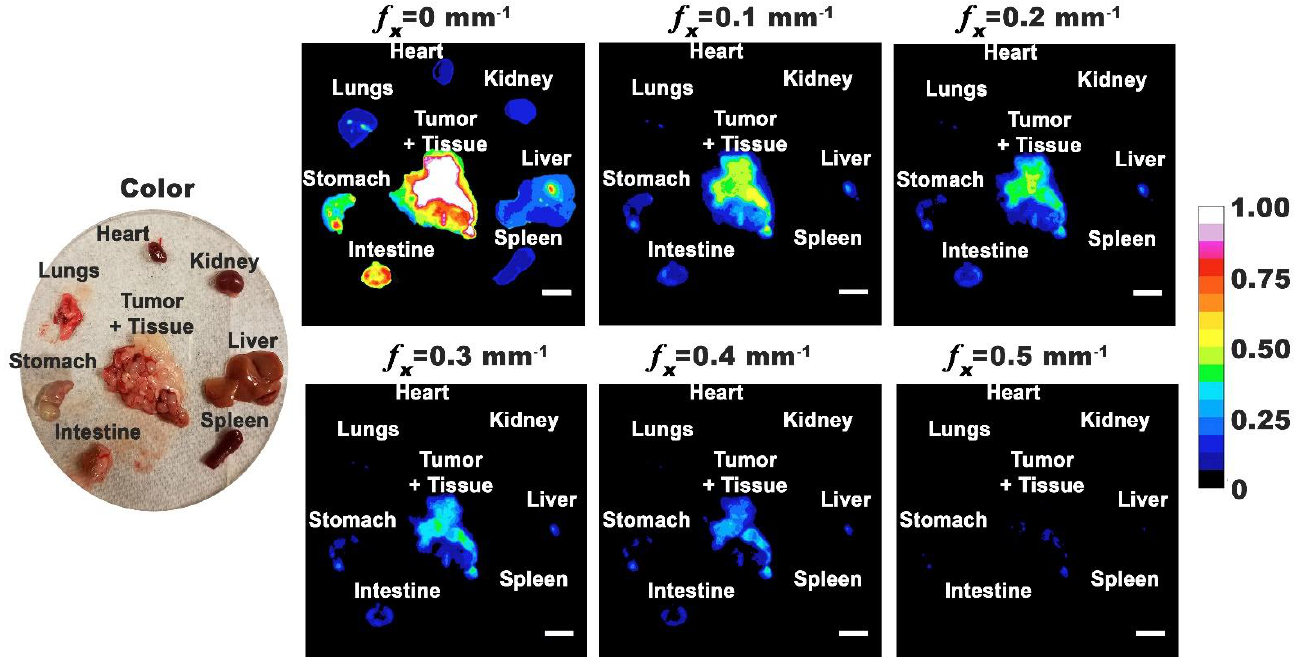
Figure 5. Representative color and normalized fluorescence images for excised organs from a mouse with ovarian intraperitoneal tumors. Images were obtained at 24 h post-intraperitoneal injection of nRBCs-ICG. SMI-based imaging at spatial frequencies in the range of 0–0.5 mm −1 are presented. The color scale bar corresponds to normalized intensity associated with the fluorescent images. White scale bars on images correspond to 10 mm.